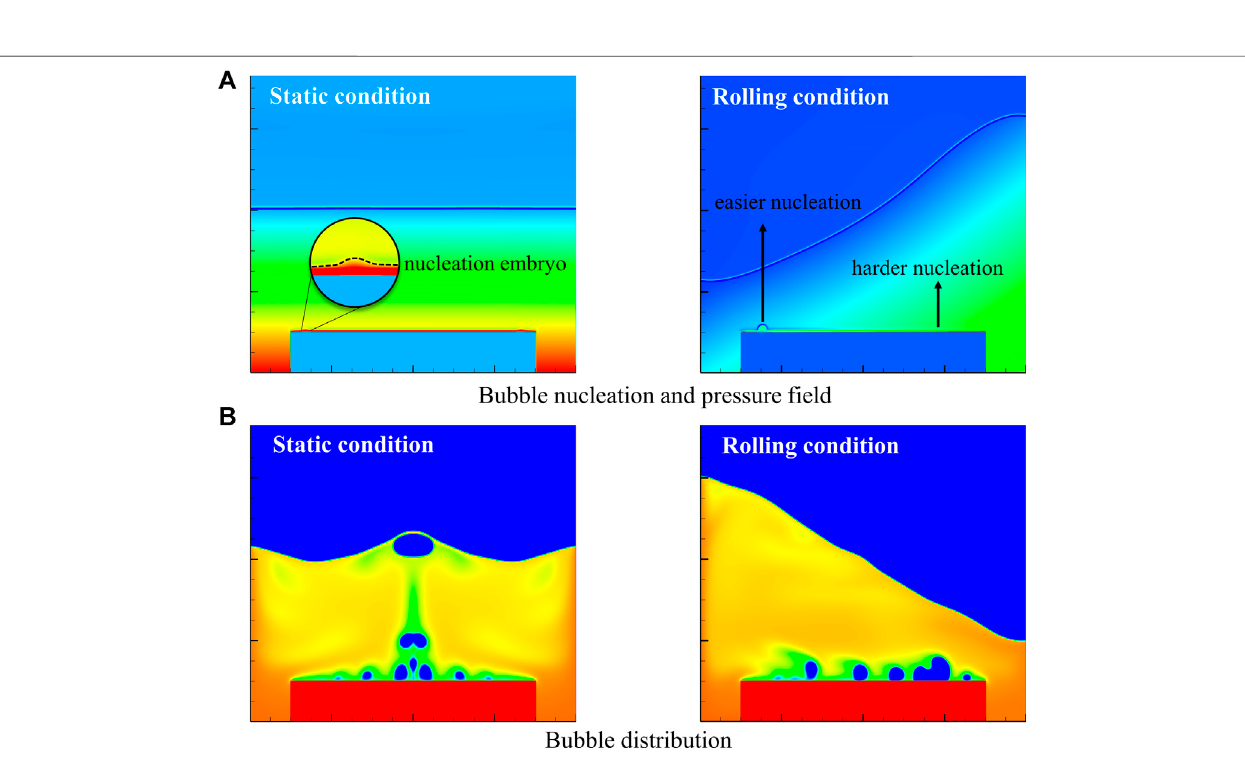
Frontiers in Energy Research |